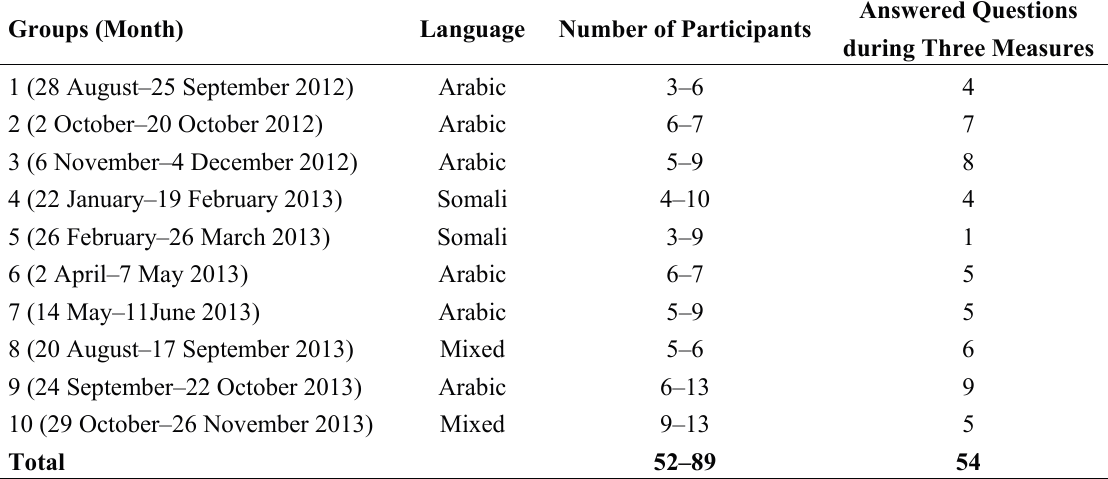
Table 2. Number of participants in each group of the 10 Lifestyle courses in Södertälje and with three